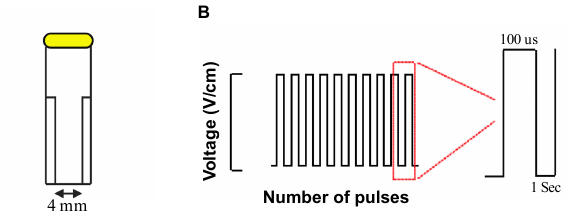
Figure 1. Irreversible electroporation experiment setup. Cell suspensions within a 4 mm gap cuvette placed in an external field ( A ) of monophasic pulses of different number and voltages in 1 Hz frequency as inter pulse interval and 100 us duration ( B ).